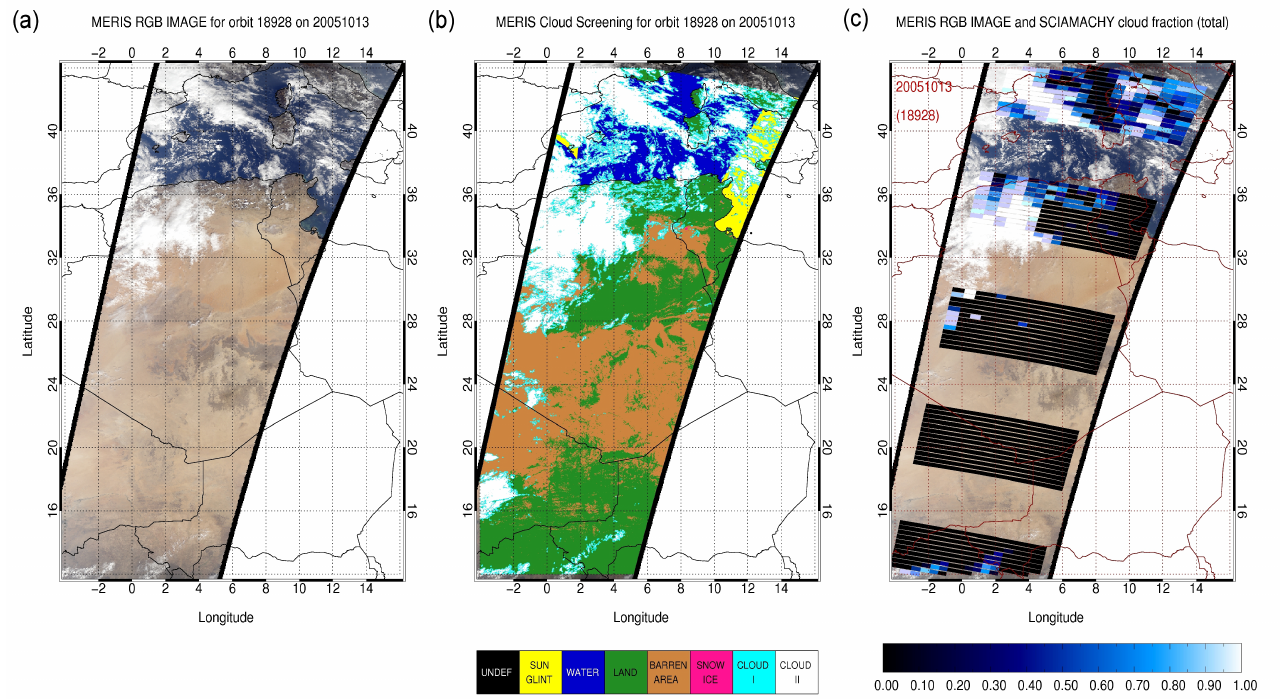
Fig. 5. Maps illustrating a section of orbit 18928 on the 13th of October 2005 covering North Africa and some part of the Mediterranean Sea: (a) MERIS RGB image, (b) MICROS-MERIS cloud screening and (c) MICROS-SCIAMACHY cloud fraction (at